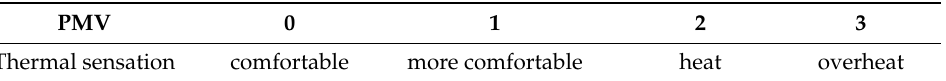
Table 1. PMV level division.